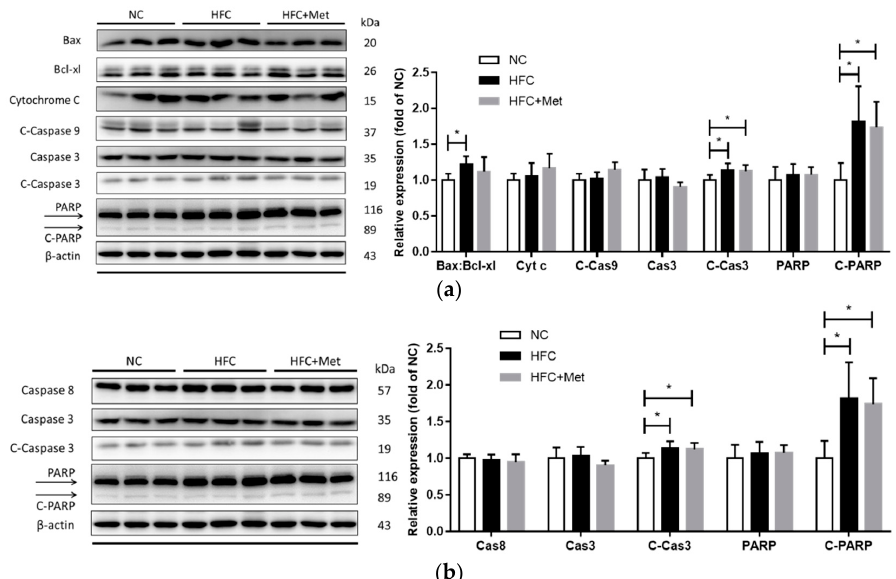
Figure 8. Effects of the high-fat and high-cholesterol diet and metformin supplementation on testicular intrinsic apoptosis pathway regulators, including ( a ) the ratio of Bax:Bcl-xl, cytochrome c (Cyt